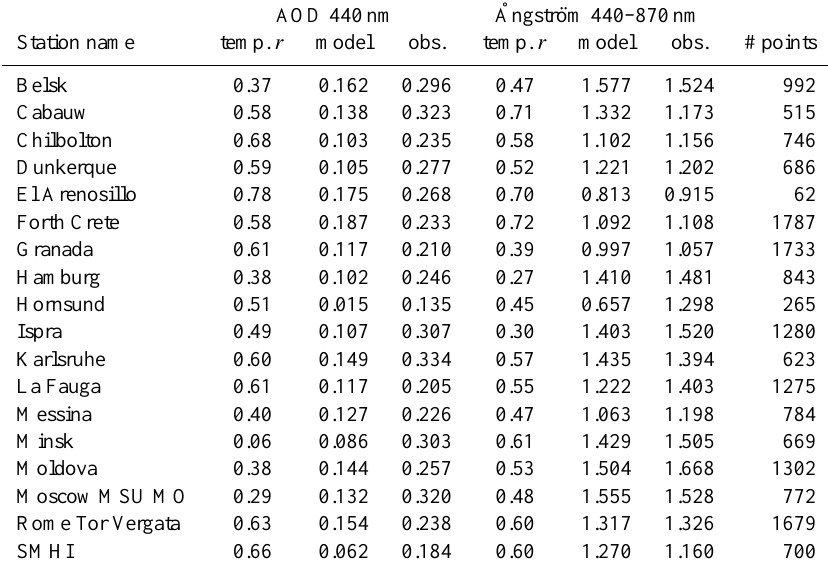
Table 5. Comparison between modelled and observed optical parameters. Listed are temporal correlations and averages of time series of the AOD 440nm and the ˚Angstr¨om parameter 440–870nm at 18 European AERONET